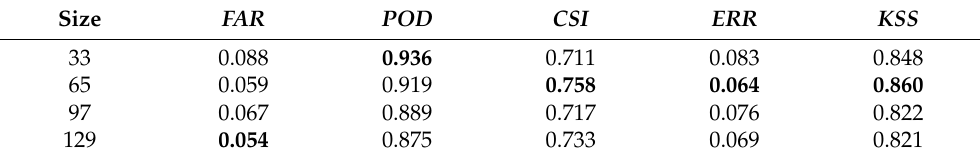
Table 2. Classification accuracy of the proposed method with different image patch sizes. Size FAR POD CSI